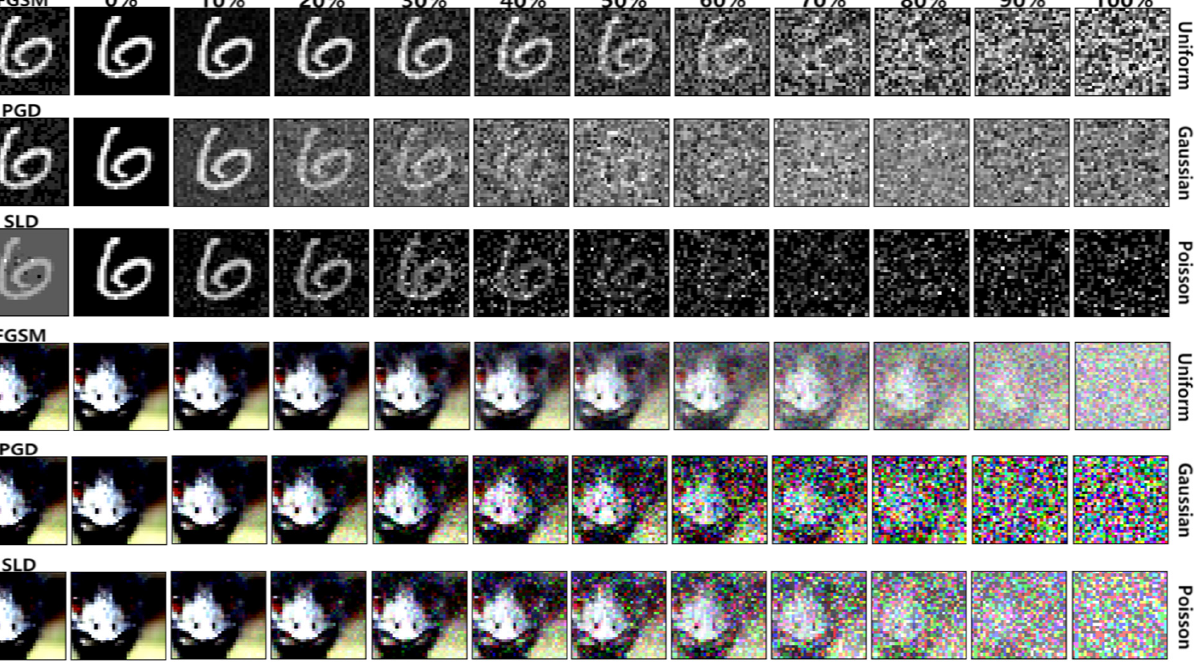
Figure 1. Example images with various amplitude noises. Rows 1, 2 and 3 were for MNIST, and rows 4, 5 and 6 were for CIFAR-10. The first column images were images with the FGSM, PGD and SLD attacks, respectively. The images in rows 1, 2, 3 or 4, 5, 6 were images with Uniform noise, Gaussian Noise, and Poisson noise, respectively.